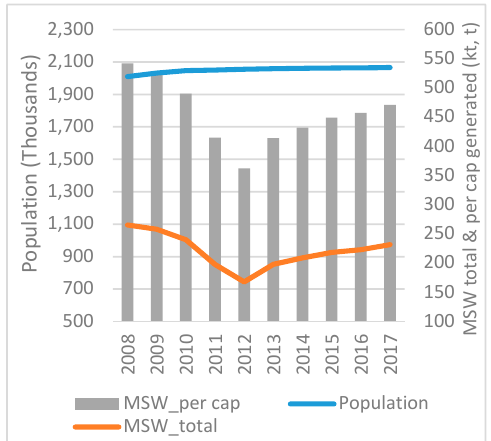
Figure 47. Population and MSW production in Slovenia 2008–2017 (EUROSTAT 2019a, 2019c).